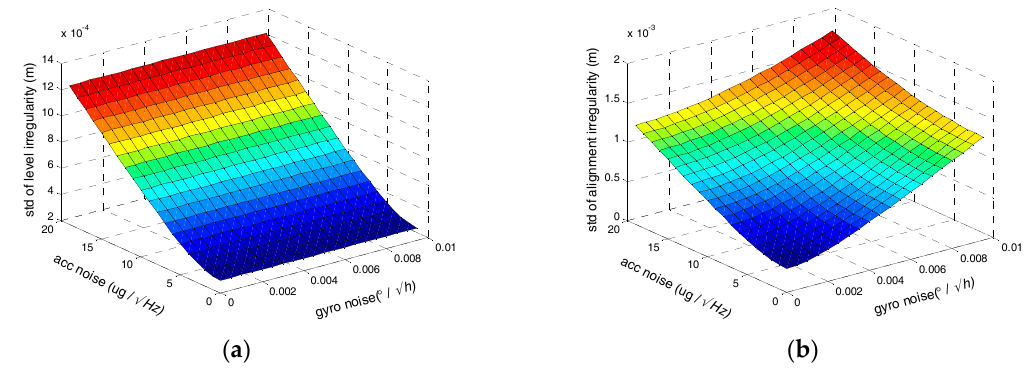
Figure 9. ( a ) The relationship between level irregularity measurement accuracy and noises of gyro and accelerometer; ( b ) The relationship between alignment irregularity measurement accuracy and noises of gyro and accelerometer.